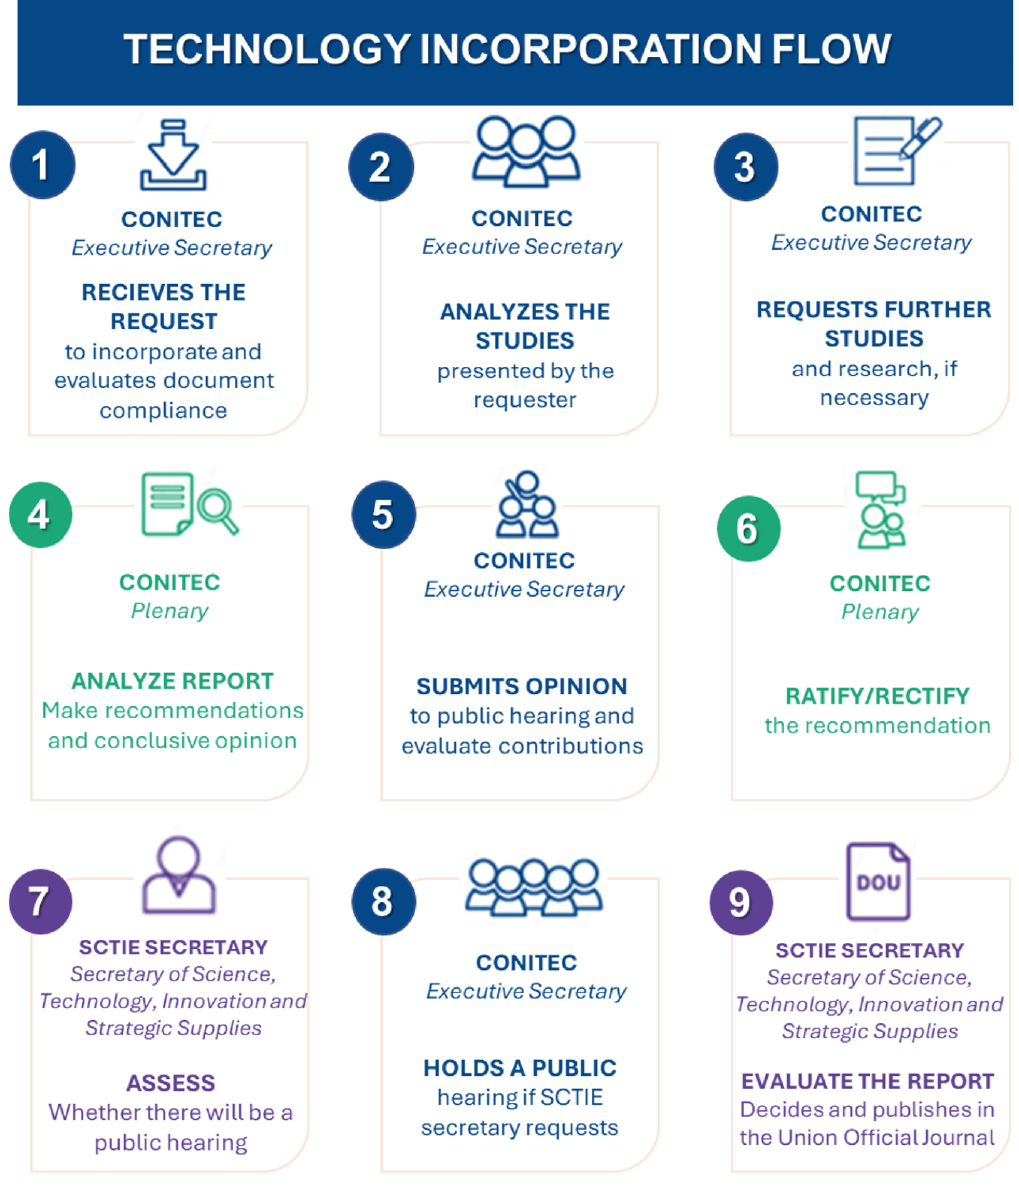
Figure 3. Incorporation steps defined by Conitec.